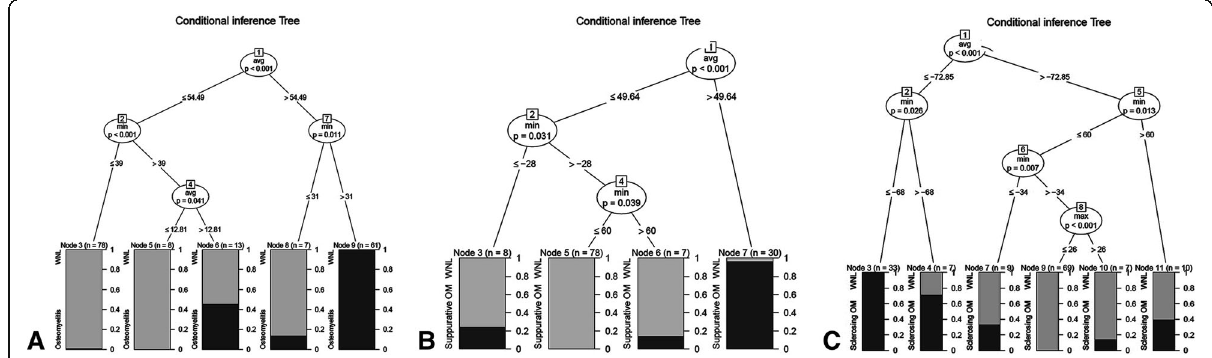
Fig. 3 Conditional inference trees showing comparison between osteomyelitis patient and control group ( a ), between suppurative bacterial osteomyelitis, suppurative BRONJ, and control group ( b ), between osteoradionecrosis, sclerosing bacterial osteomyelitis, sclerosing BRONJ, and control group ( c